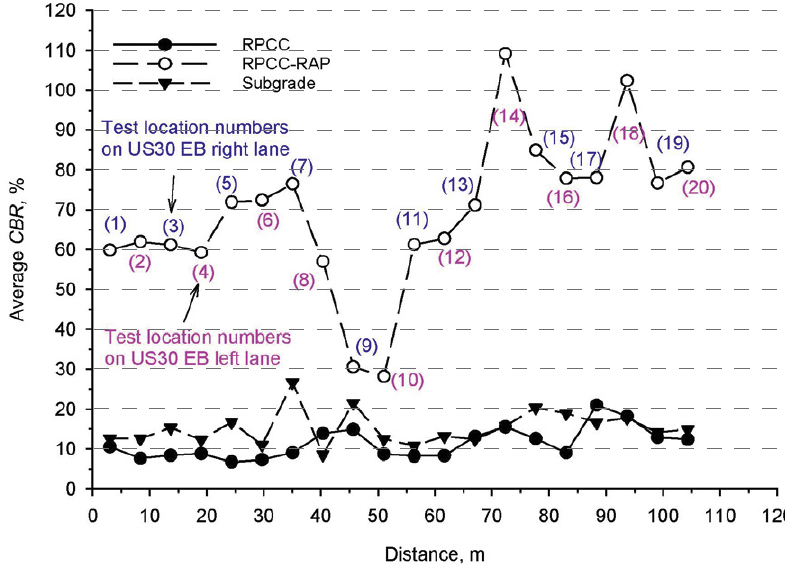
Figure 4. Layer California Bearing Ratio values at each test location